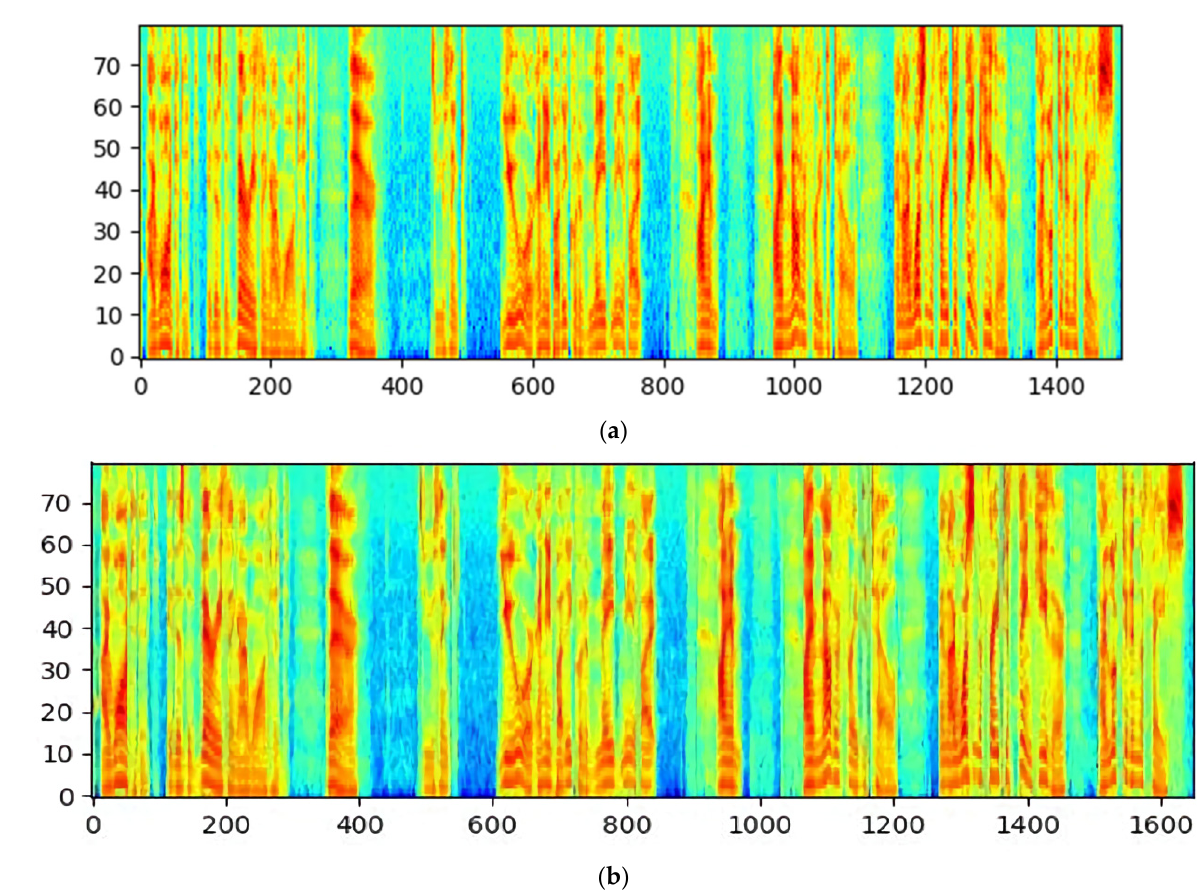
Figure 9. Comparison of the spectrograms with frame index on x -axis and feature index on y -axis. The length of the utterance increases due to FrameAugment. ( a ) Original spectrogram; ( b ) spectrogram with FrameAugment ( s = 1.3, n = 500, p =